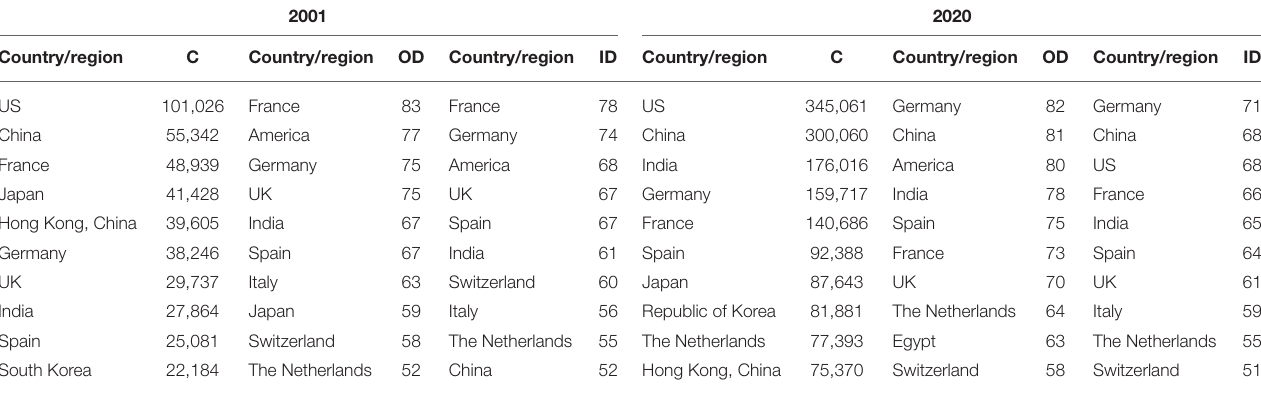
TABLE 1 | Top 10 countries by weighted degree, weighted in-degree, and weighted out-degree in 2001 and 2020. 2001